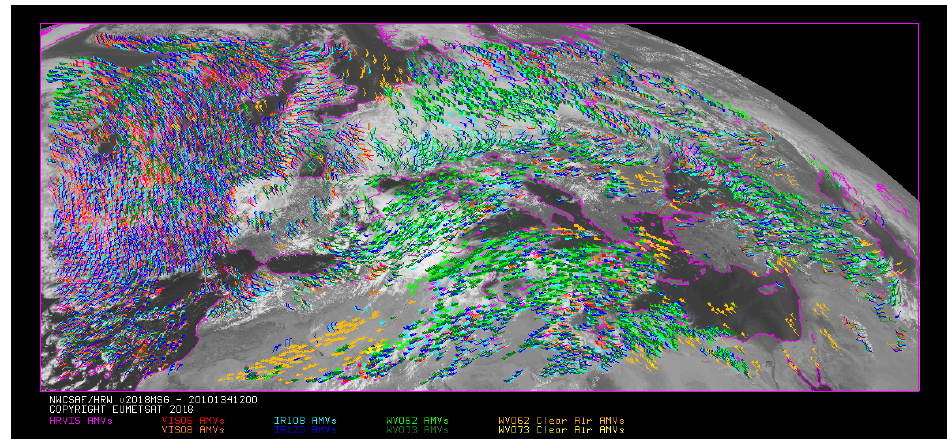
Figure 4. ‘Basic scale AMVs’ (in red), and ‘detailed scale AMVs’ (in yellow, green, and blue, considering their relationship with the basic scale AMVs), in a two-scale NWC/GEO-HRW example for the European and Mediterranean region, with the default conditions for MSG satellites (14 May 2010, 12:00 UTC, MSG-2 satellite).